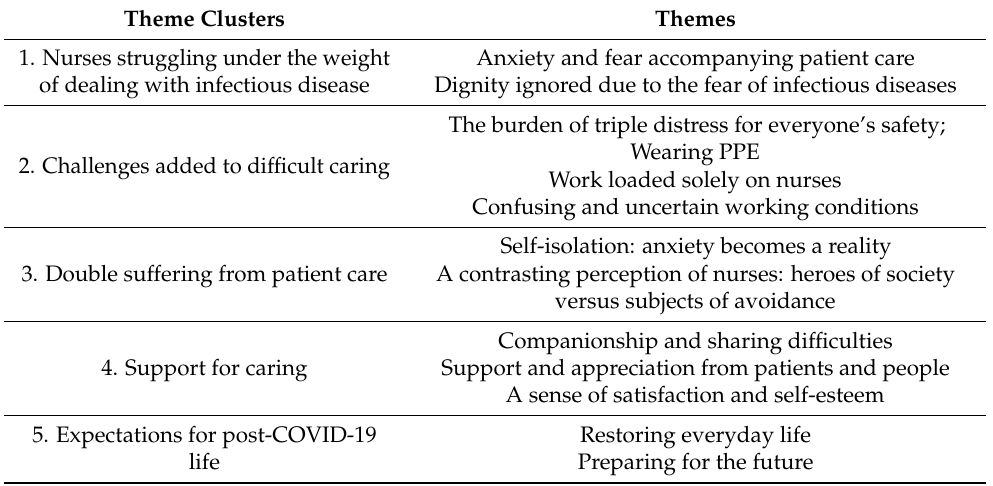
Table 2. Theme Clusters and